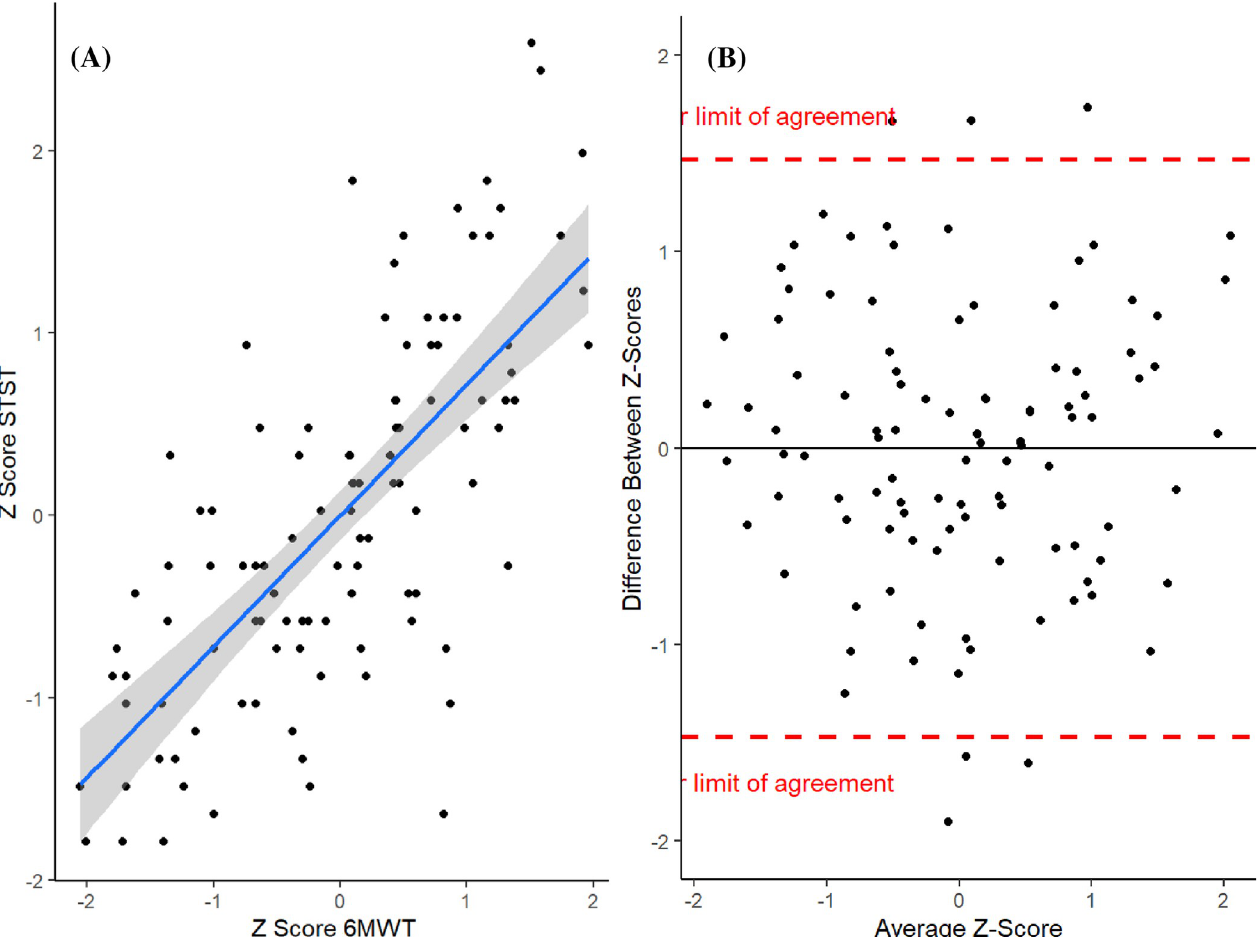
Fig 1. 1-min STST versus 6MWT. (A) Correlation between z-scores of the 1-min STST and 6MWT and ( B) corresponding Bland Altman plot. The solid line represents the mean difference of the methods (mean bias) and the dashed lines indicate the upper and lower limit of agreement. Filled circles represent individual measurements. Abbreviations . 1-min STST = one-minute sit-to-stand test; STST = sit-to-stand test; 6MWT = six-minute walk test.